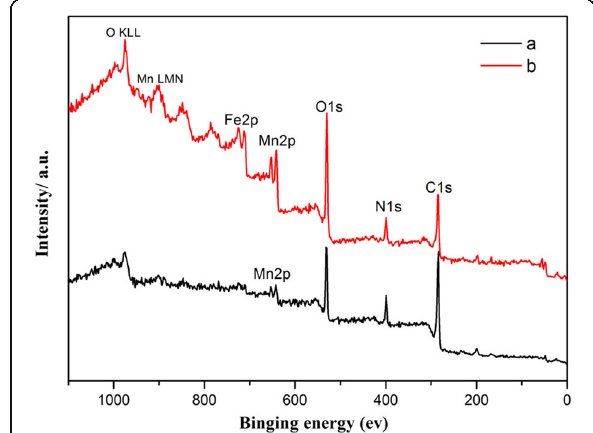
Fig. 3 XPS spectra of (a) 30 μ L PPy-coated urchin-like MnO 2 sample and (b) 50 μ L PPy-coated caddice-clew-like MnO 2 sample